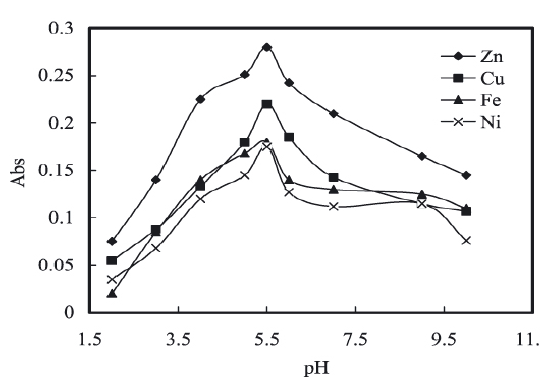
Figure 1. Effect of pH on cloud point extraction of analyte ions